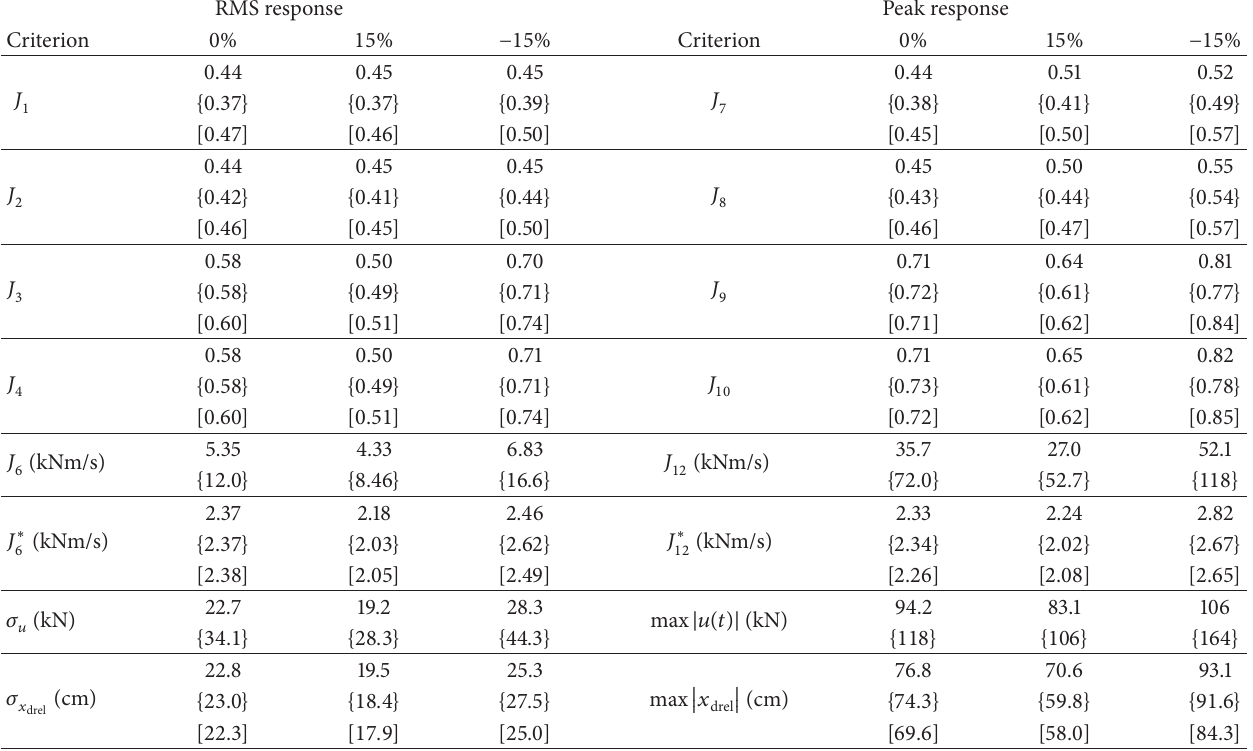
Table 1: Performance criteria: STLC compared with ALC and STSC, for 0 % and ± 15% structural stiffness